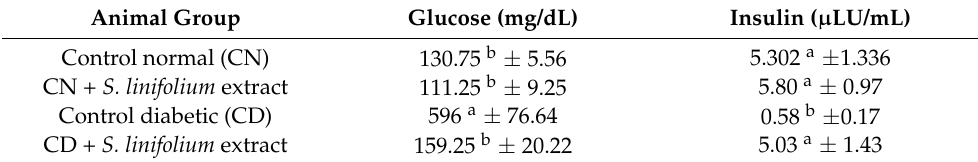
Table 3. Serum glucose and insulin levels in the treated rat groups.